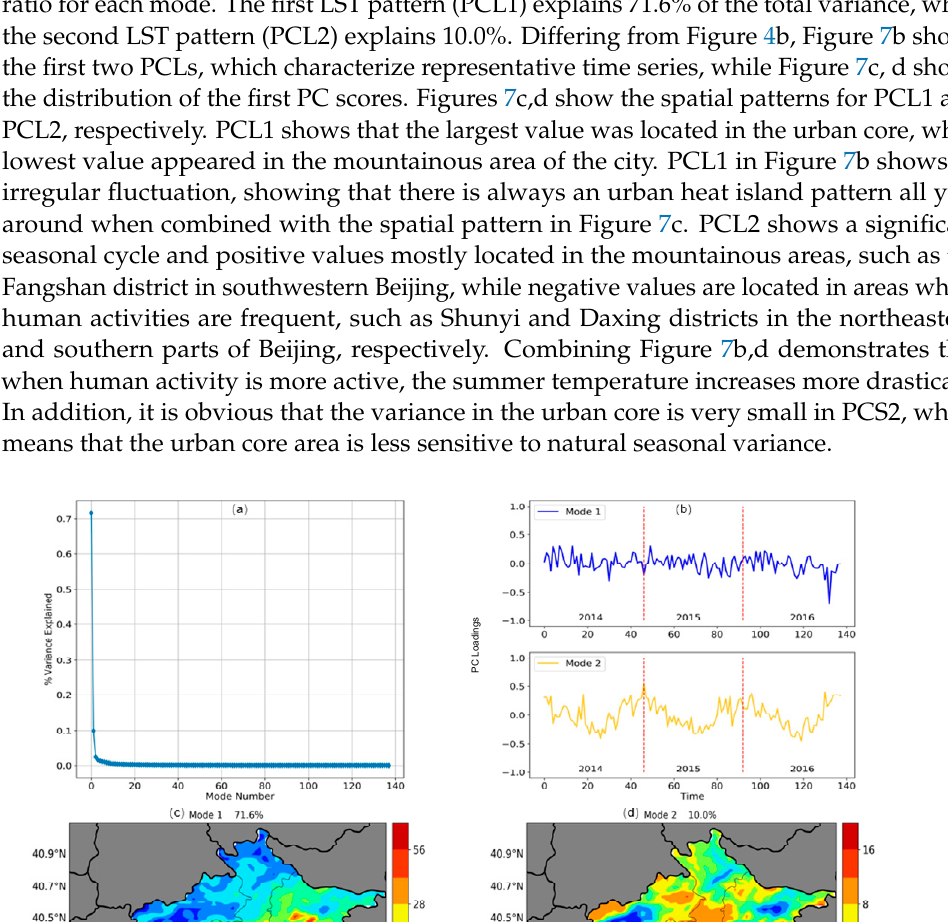
Figure 8. The T-mode PCA results for Beijing DNB data during 2014–2016, ( a ) the variance explained by the principal covariance analysis (PCA) modes for surface temperatures, ( b ) the PC time series for the first two modes (the red vertical lines are used to divide data into different years, ( c , d ) the spatial patterns of the first two modes for PCA results.